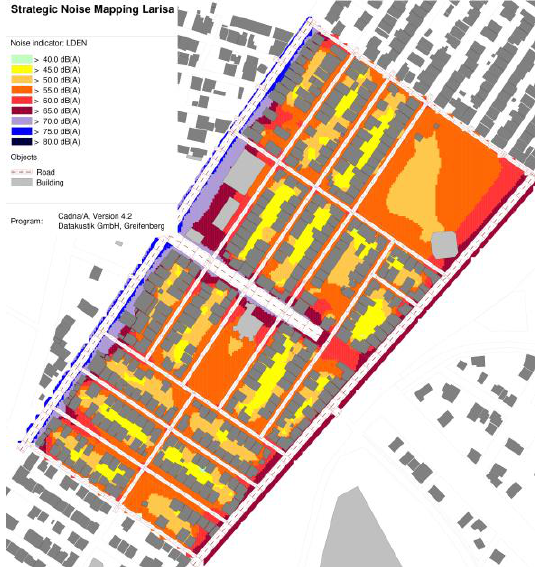
Figure 6. SNM: L den simulation (Larissa SNM — Greece — Urban Area of Echekratidos): visualization of silence islet in between buildings blocks.